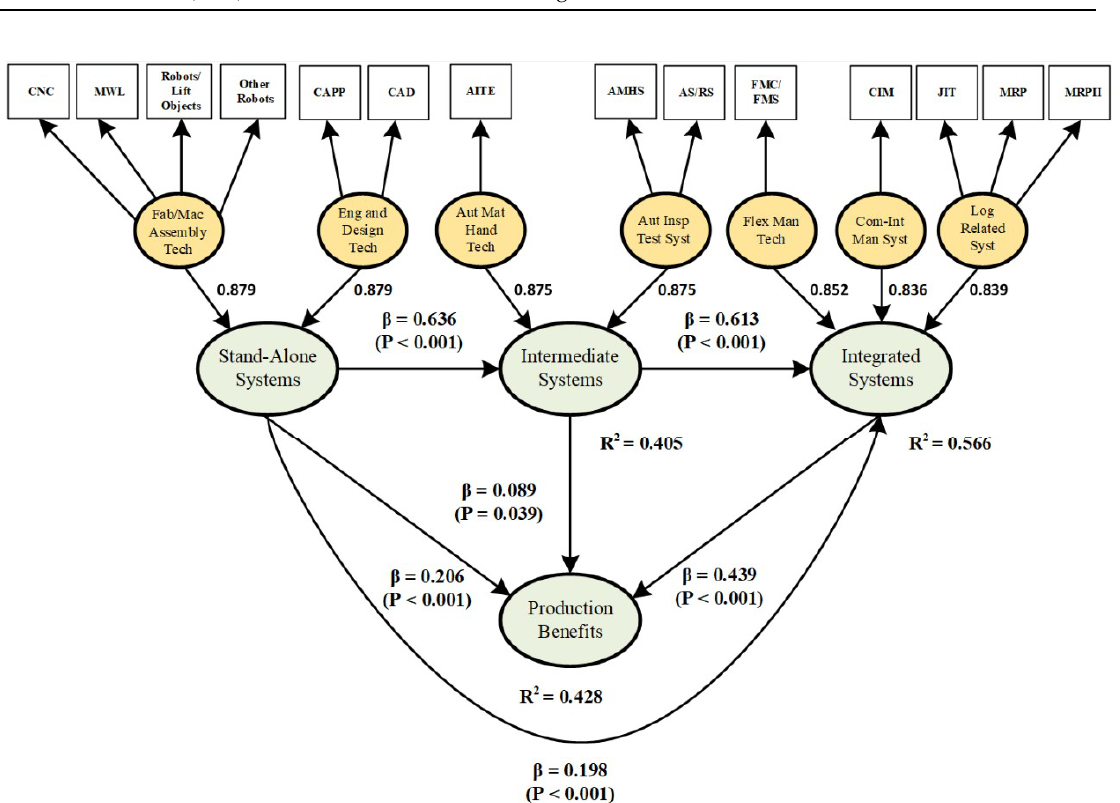
Figure 3. Evaluated Model.